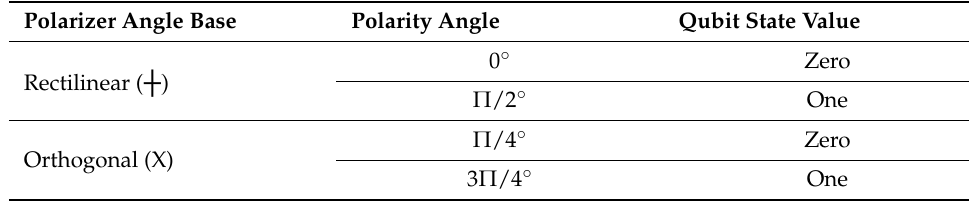
Table 3. BB84 qubit SOP-based encrypting design.